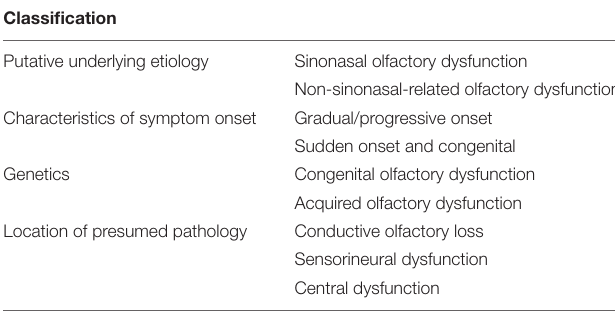
TABLE 3 | Classifications of olfactory